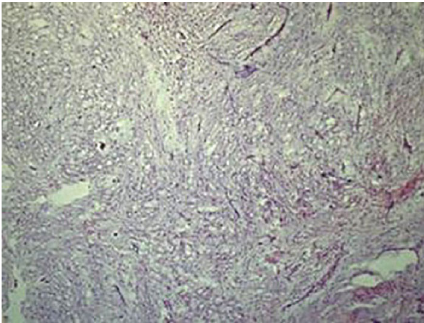
Figure 6: Bone splitting with piezo bone saw during implant placement.